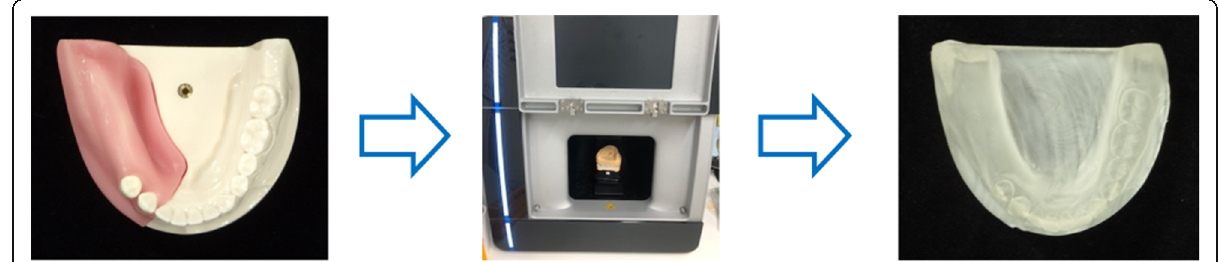
Fig. 2 Flow chart of resin model production. Eighteen resin models were created from three-dimensional (3D)